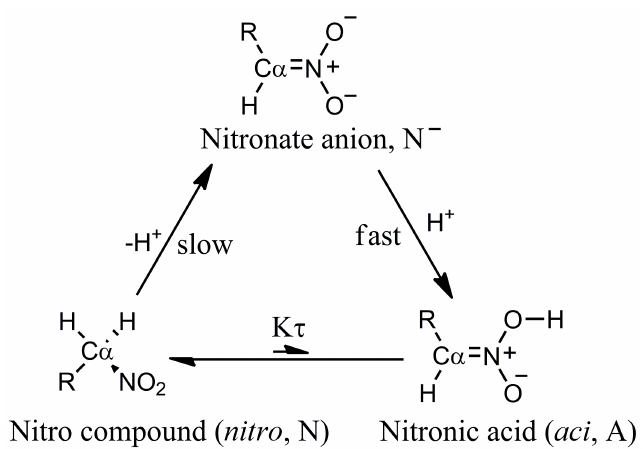
Figure 1. Schematic picture of species involved in the acid-base equilibria of nitro compounds.